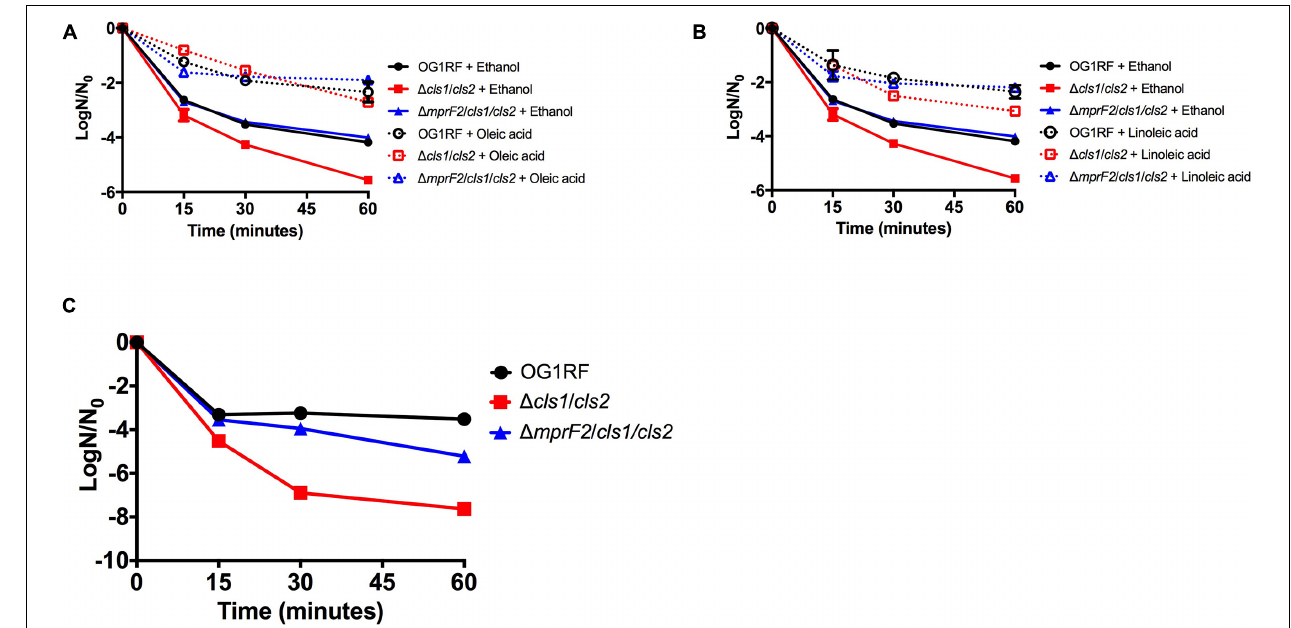
FIGURE 5 | Stress sensitivity upon loss of phospholipid synthetic pathways is dependent upon genetic background. (A) Oleic acid supplementation of (cid:49) cls1/cls2 and (cid:49) mprF2/cls1/cls2 had statistically increased numbers of survivors vs. the solvent control when treated with daptomycin at all-time points ( P < 0.0001). (B) Linoleic acid supplementation of (cid:49) cls1/cls2 and (cid:49) mprF2/cls1/cls2 had statistically increased numbers of survivors vs. the solvent control when treated with daptomycin at all-time points ( P = 0.0001). Shown are the averages ± standard deviation for n = 3. (C) SDS sensitivity of indicated strains grown in exponential phase. Shown are the averages ± standard deviation for n =